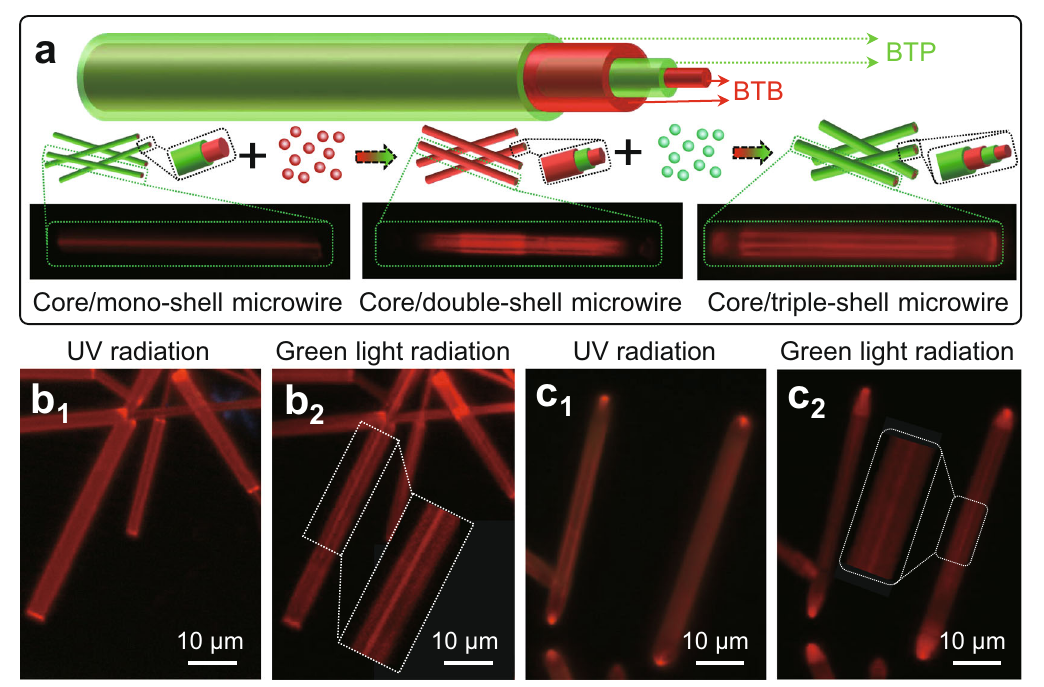
Fig. 3 Core/multi-shell organic microwires. a The horizontal epitaxial-growth approach for the core/multi-shell organic microwires. b FM images of the core/double-shell organic microwires excited with b 1 the UV light and b 2 green light. c FM images of the core/triple-shell organic microwires excited with c 1 the UV light and c 2 green light. Scale bars of b and c are 10 μ